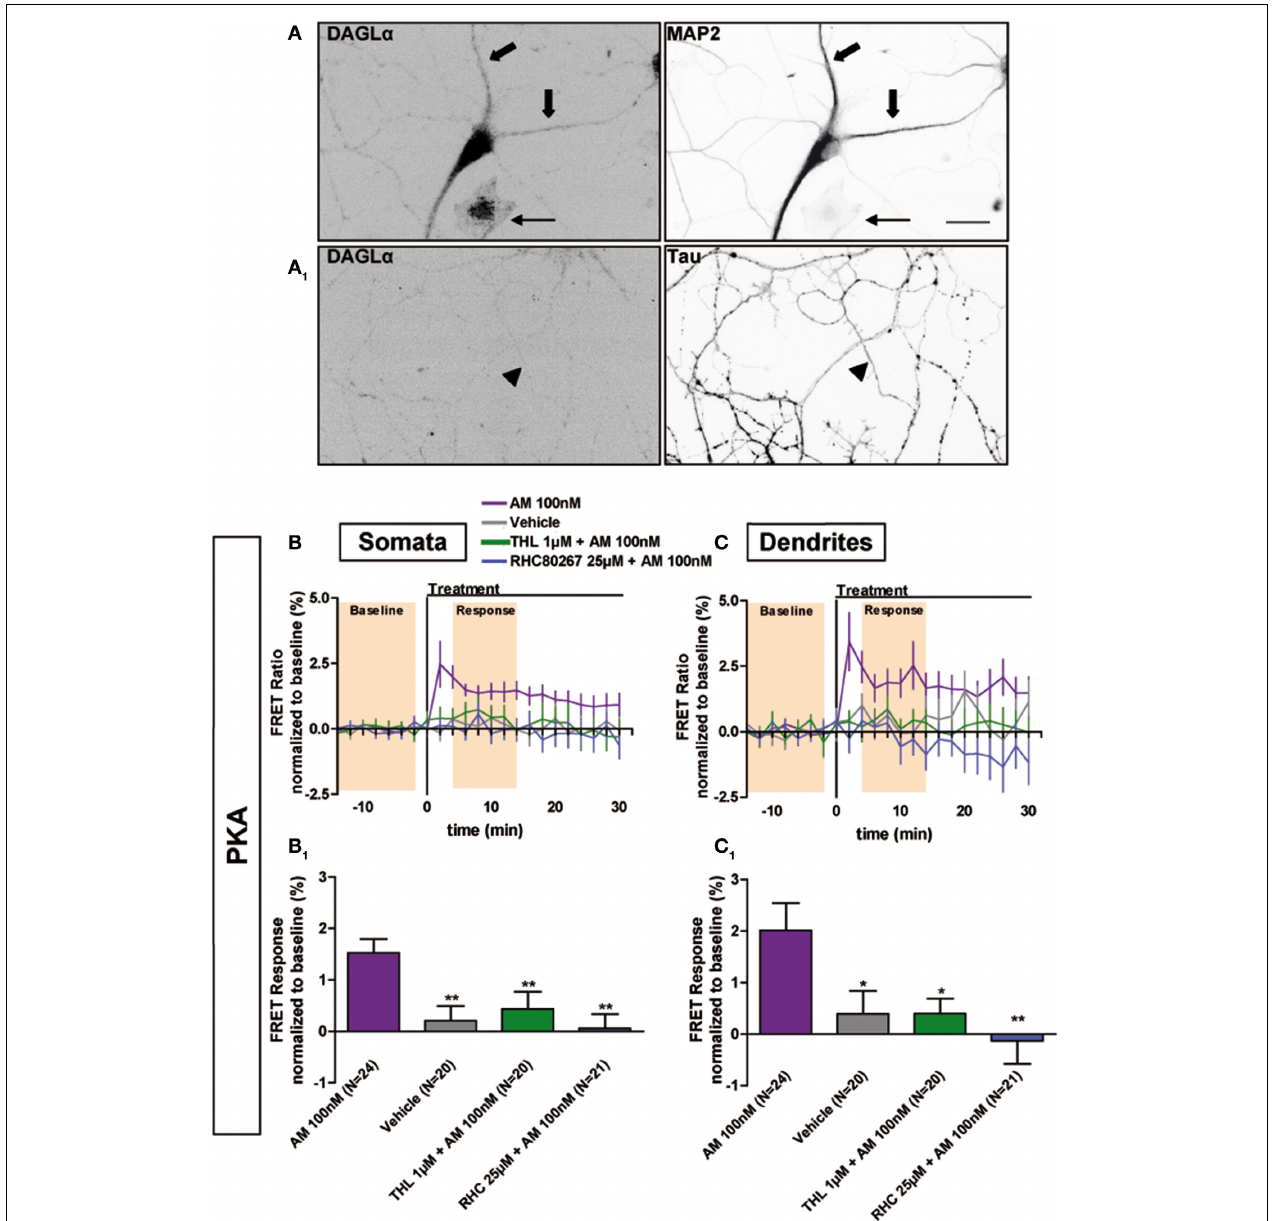
FIGURE 4 | Constitutive activation of somatodendritic CB1Rs requires locally synthesized endocannabinoids. (A) Simultaneous immunolabeling of fully-polarized (DIV9) neurons with anti-DAGL α antibody and either anti-MAP2 (A) or anti-Tau (A 1 ) antibodies. Large arrows indicate dendrites, arrow-heads indicate axon and the thin arrow shows an astrocyte. (B,C) Averaged somatic and dendritic responses of AKAR4-Kras expressing neurons to inverse-agonist AM281 (AM), with or without inhibiting DAGL activity. The FRET ratio normalized to baseline was calculated for each neuron